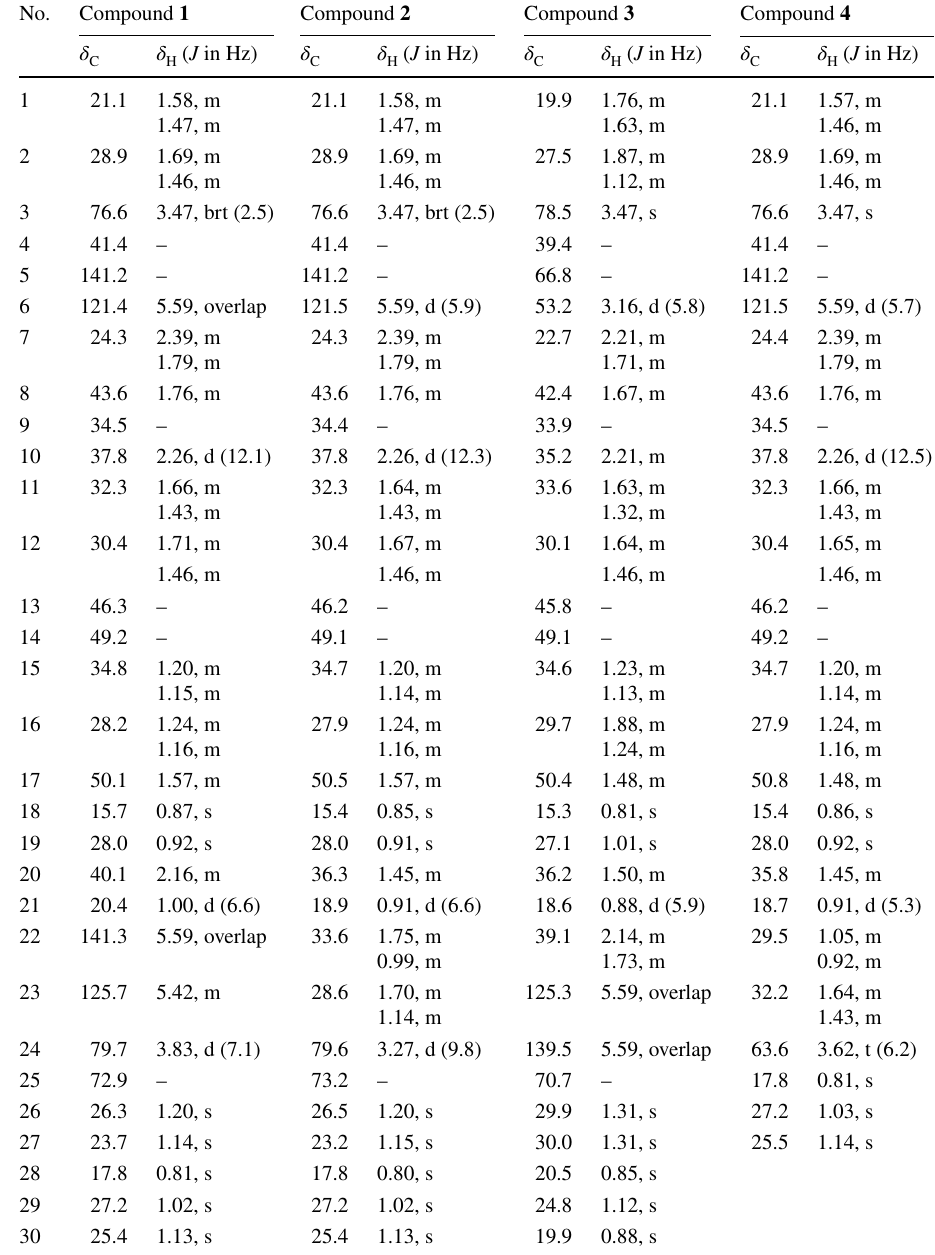
Table 1 1 H (500 MHz) and 13 C (125 MHz) NMR spectroscopic data of compounds 1 – 4 in CDCl 3